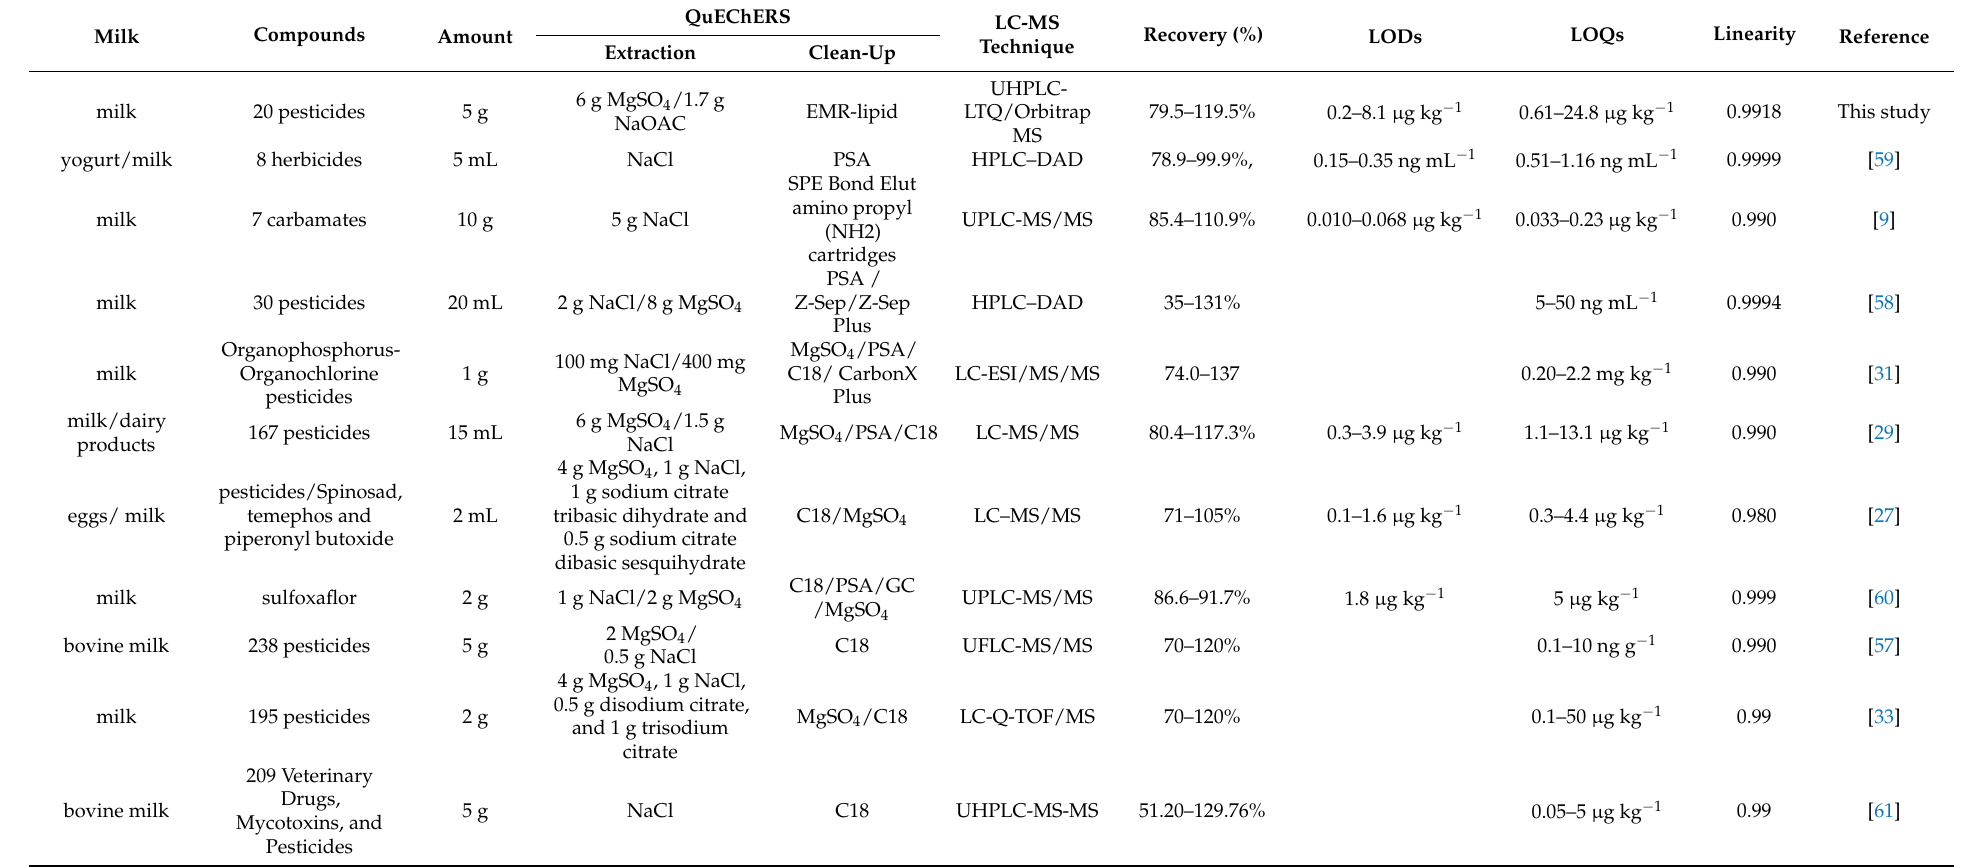
Table 3. Main characteristics of recent studies regarding QuEChERS extraction and LC-MS techniques for the analysis of pesticides in